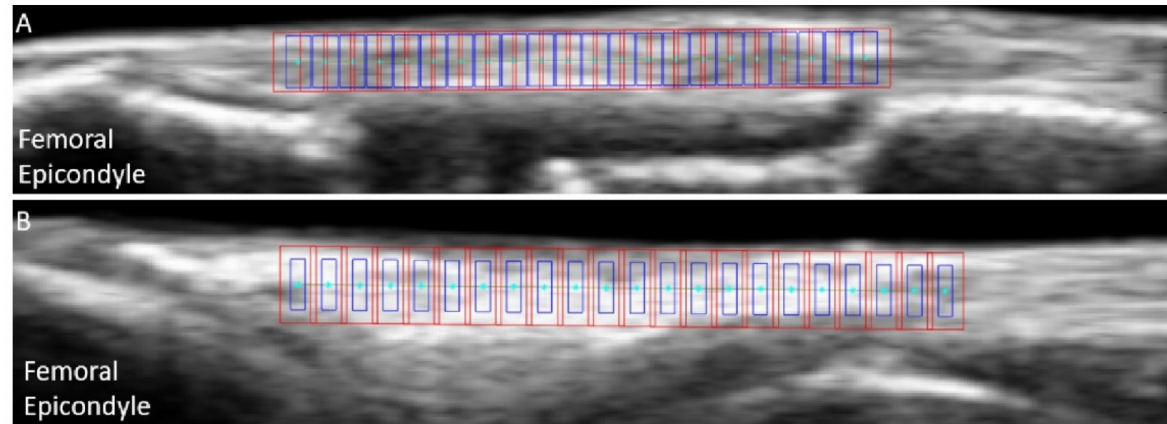
Figure 3. Example of initial nodes positions (cyan) overlaid on b-mode ultrasound images of the medial collateral ligament ( A ) and lateral collateral ligament ( B ), with the associated kernels (blue) and search windows